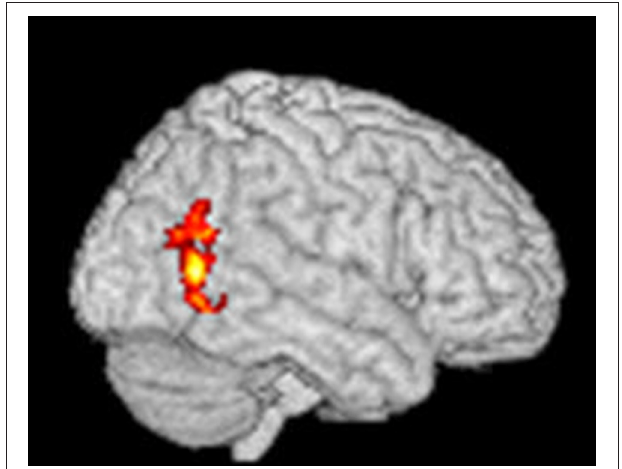
FIGURE 4 | Statistical fMRI image showing the areas of brain where there was a significant paired decrease from pre-treatment to post-treatment using verbally cued imagined alcoholic beverage craving stimuli to elicit craving-related brain activation before and after aversive conditioning. The red areas show where there was a significant change in fMRI at a corrected p -value < 0.05 and the yellow areas show where there was a significant change in fMRI at a corrected p -value < 0.03.